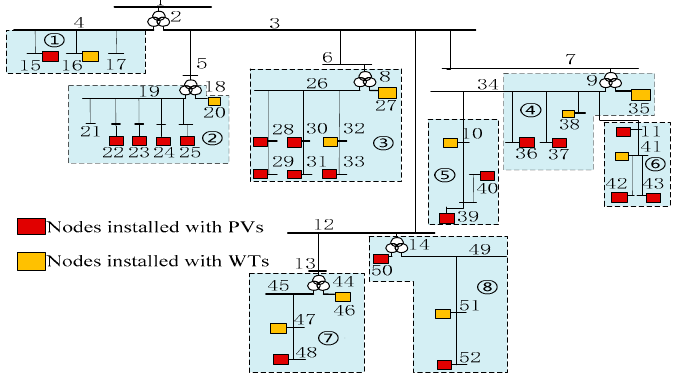
Figure 9. Topology of an actual network and the results of cluster partition.